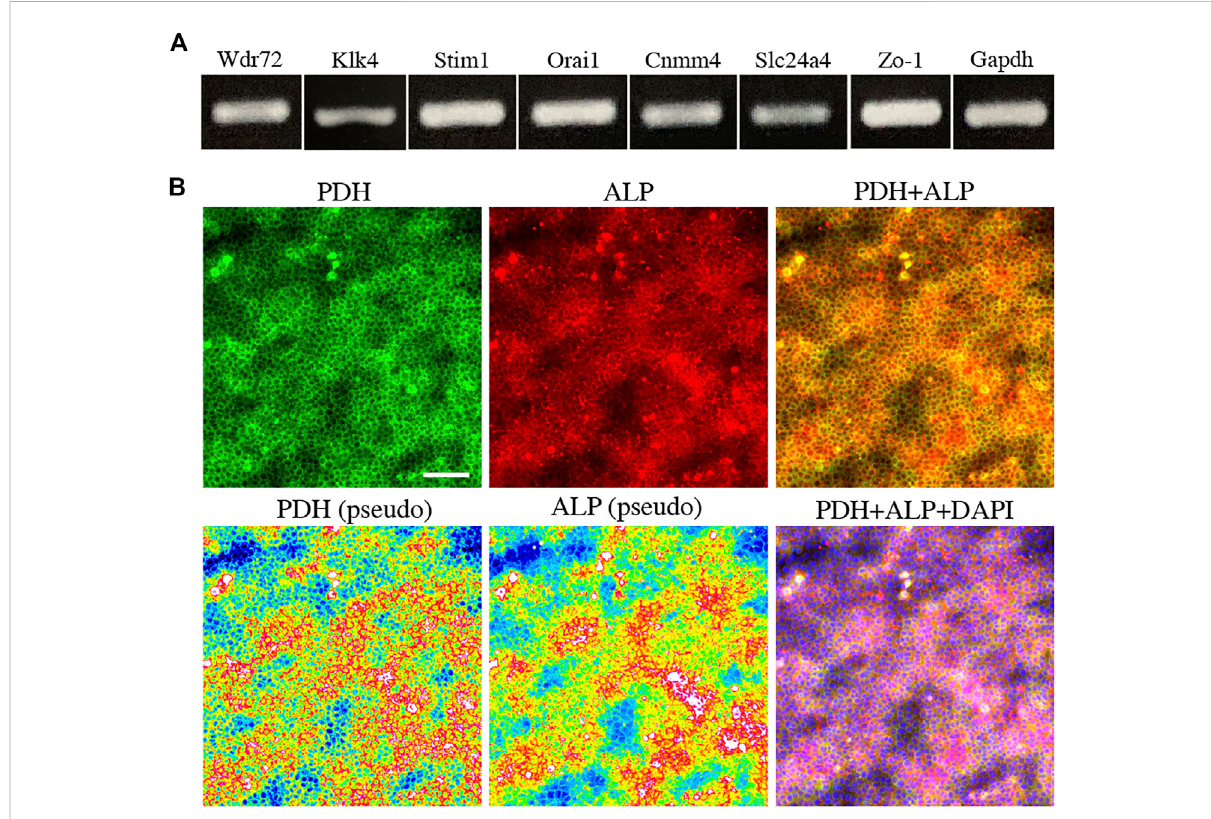
FIGURE 3 The expression of marker for maturation stage ameloblasts and energy metabolism in HAT7 cells. (A) The expression of maturation stage ameloblasts marker in HAT7 cells, as determined by RT-PCR. (B) Double staining of PDH and ALP in HAT7 cells. The bottom left and bottom middle images are the pseudo-color images of PDH and ALP, respectively. The nucleus is stained with DAPI (blue). Scale bars: 50 μ